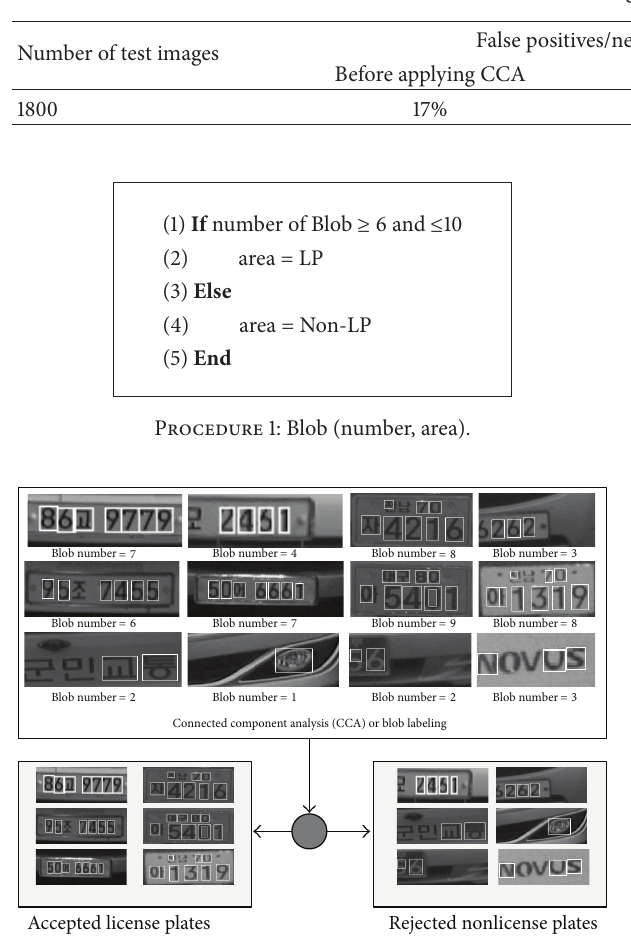
Figure 16: Verifying images with CCA and saving LP images.